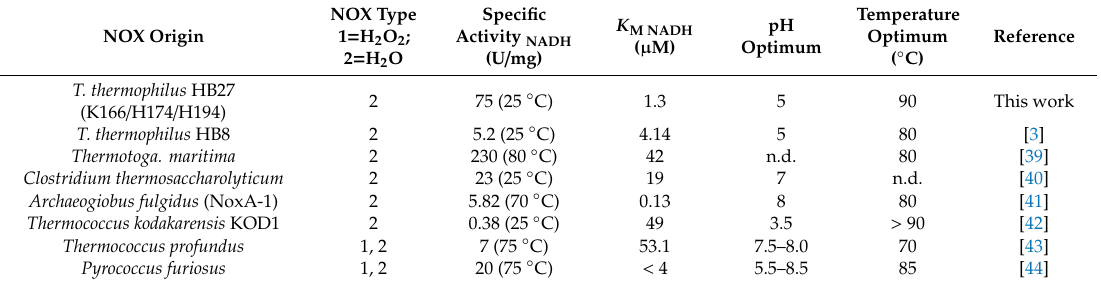
Table 3. Summary of published data from characterization of NOXs enzymes from di ff erent